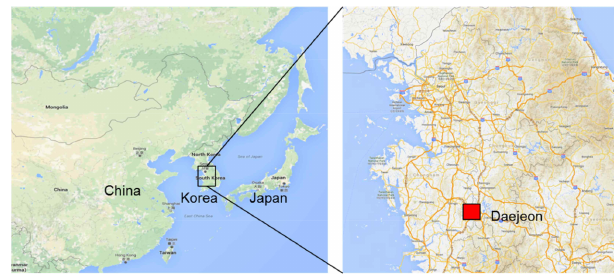
Figure 1. Map of the measurement site (36.19 ◦ N, 127.24 ◦ E) in Daejeon, South Korea (base map is from Google